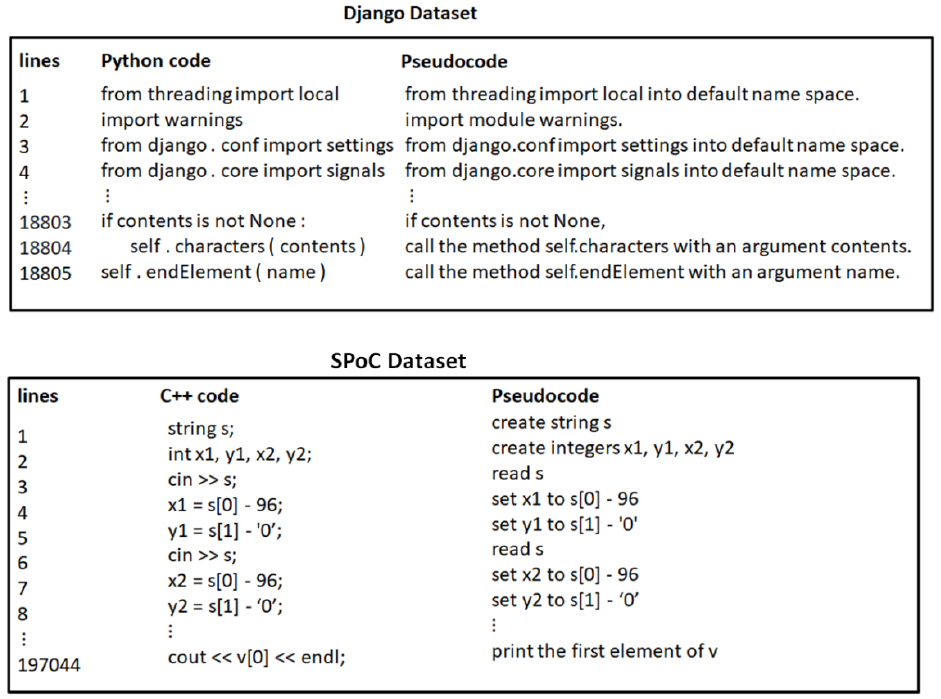
Figure 4. Examples of Django and SPoC datasets.